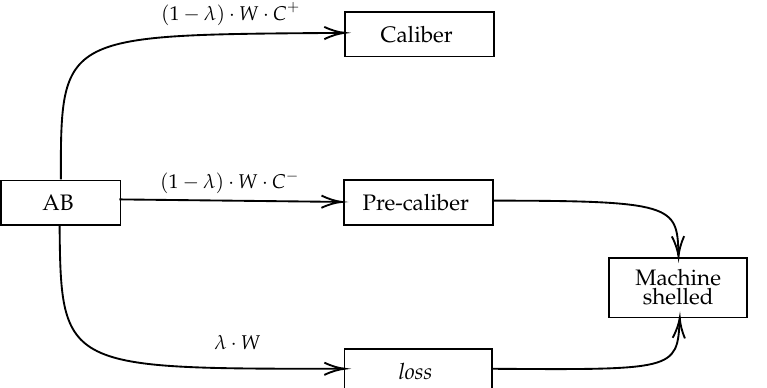
Figure A2. Separation of an AB by walnut size, showing how many kilograms of walnut go into each group. In the diagram, λ represents the loss percentage of the process (a parameter of the separator machine), W is the total kilograms in the AB, C − the proportion of pre-caliber walnuts, and C + the proportion of caliber